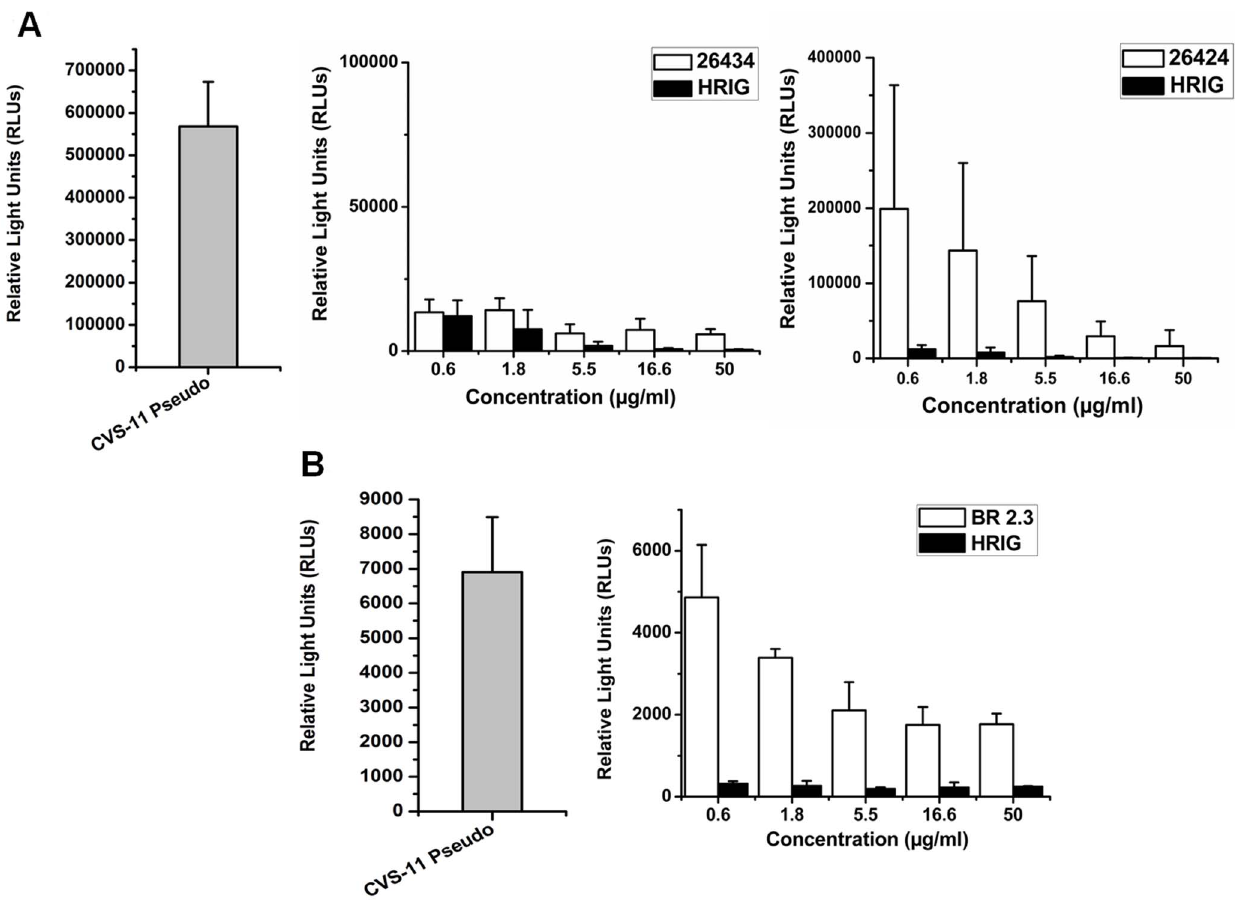
Figure 5. Invitro neutralization of CVS-11 pseudotypes by 26424, 26434 and BR 2.3. (A) BHK-21 cells were seeded into 96-well plate at 5 6 10 3 cells per well along with pseudotypes (CVS-11 pseudo) with an input of 6 6 10 5 RLUs. Wells treated with 26434 and 26424 as well as HRIG (positive control) showed inhibition of infection through decrease in RLUs, indicative of virus neutralization. The neutralization efficiencies with serial dilutions of 26424, 26434 and HRIG are depicted with reference to RLUs. (B) Neutralization assay of BR 2.3, a control sdAb in the monomer format isolated from the same naı¨ve llama library. Lower titer of CVS-11 pseudotypes (7 6 10 3 RLUs) was used to infect BHK-21 cells. Based on the ability to inhibit luciferase expression of the transduced cells, combodies 26424 and 26434 were able to neutralize 85-fold increased input of CVS-11 pseudotypes as compared to the monovalent BR 2.3. The relative neutralizing ability of 26424, 26434, and BR 2.3 were compared with similar concentrations of HRIG, currently used for post exposure prophylaxis (PEP) in rabies infection. All assays were carried out in triplicates and the graphs represent the average value. Standard deviations ( 6 SD) are indicated by bars.